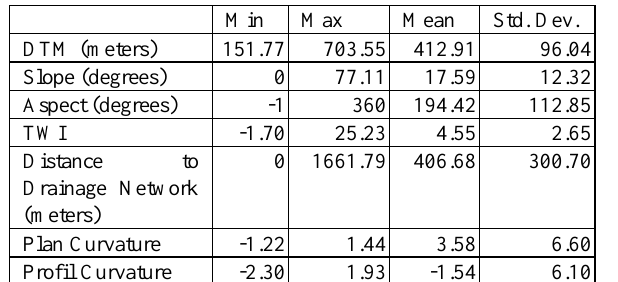
Table 2. Statistical summary of the topographical data obtained for the landslide inventory area dataset.